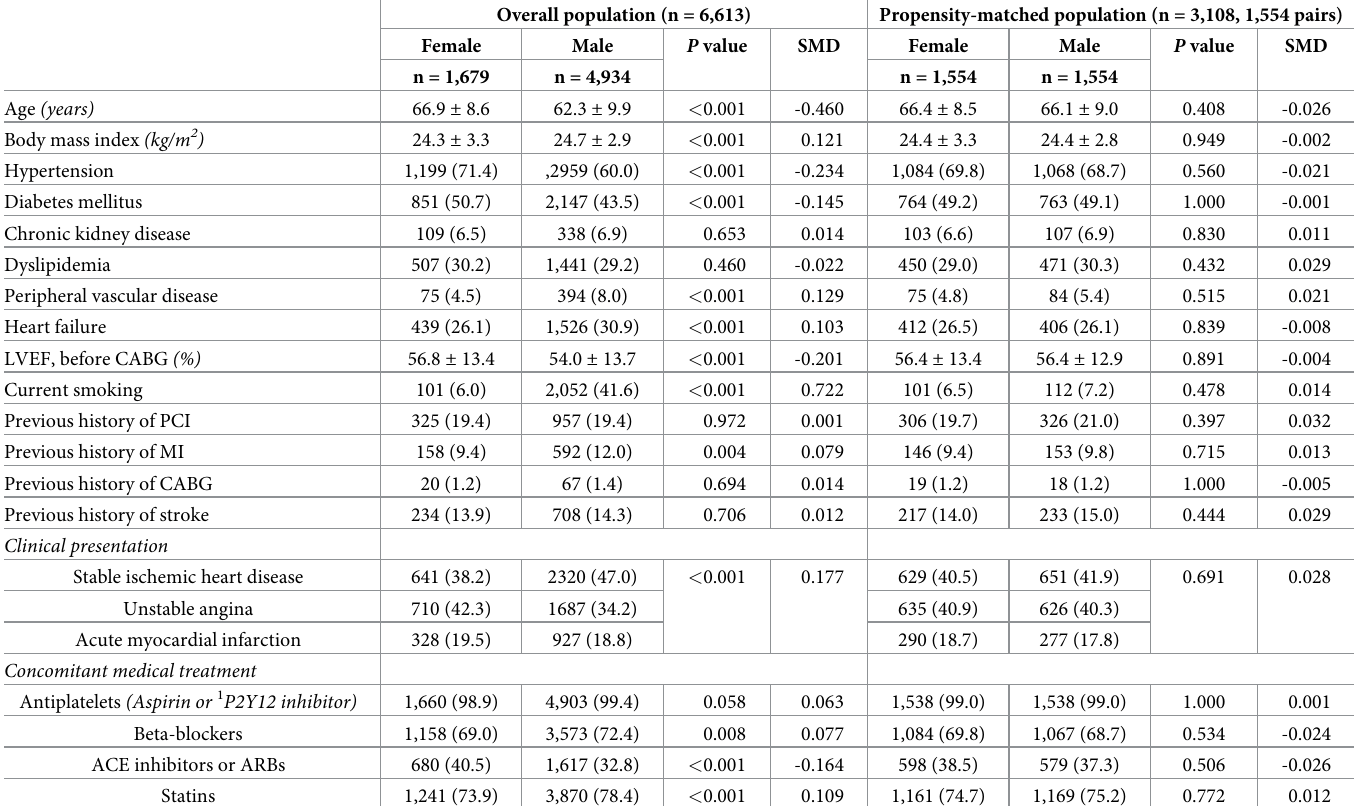
Table 1. Baseline clinical